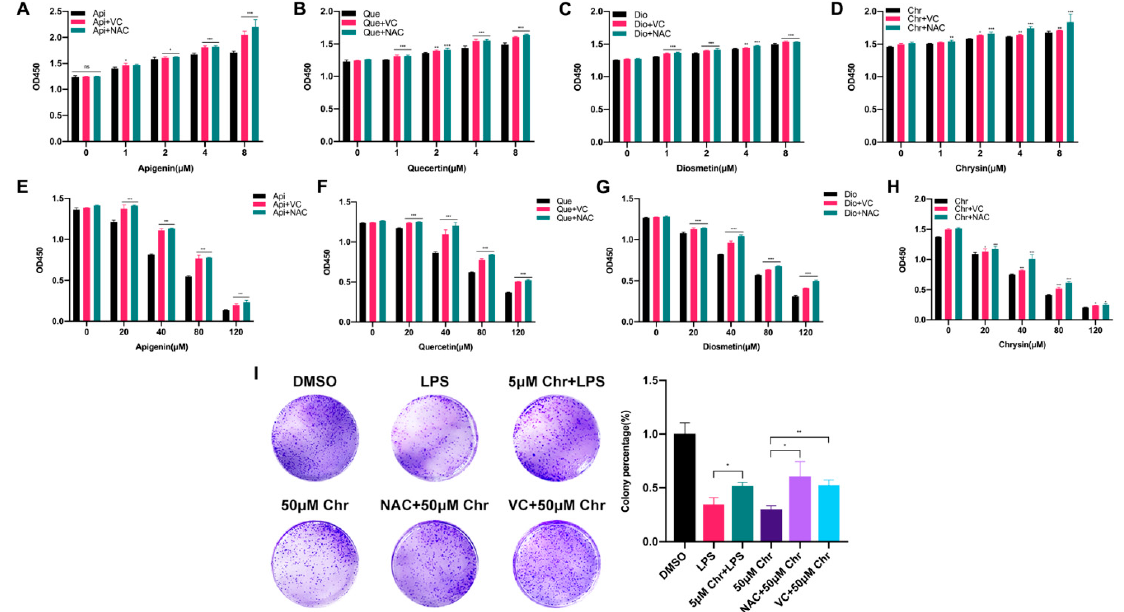
Figure 2. The dual effects of flavonoids on the proliferation of MCF-7 breast cancer cells depending on different drug doses. ( A ) The cell number of MCF-7 cells pretreated with NAC or VC for 6 h and thereafter receiving the indicated dose of apigenin for 60 h. ( B ) The cell number of MCF-7 cells pretreated with NAC or VC for 6 h and thereafter receiving the indicated dose of quercetin for 60 h. ( C ) The cell number of MCF-7 cells pretreated with NAC or VC for 6 h and thereafter receiving the indicated dose of diosmetin for 60 h. ( D ) The cell number of MCF-7 cells pretreated with NAC or